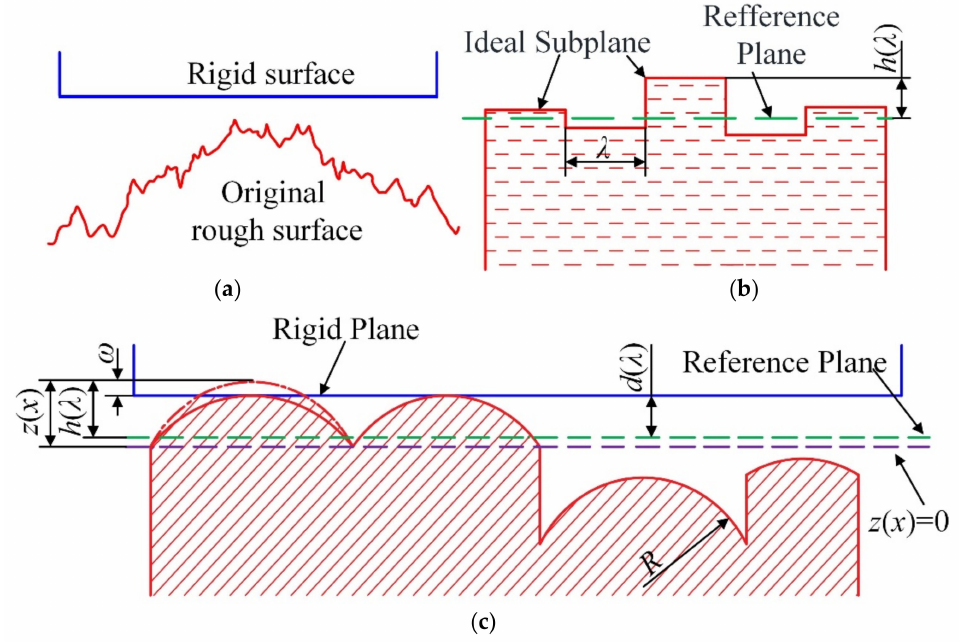
Figure 1. The contact of two rough surfaces. ( a ) The contact of two rough surfaces can be idealized as a rigid plane pressed on a deformable rough surface. ( b ) The fractal surface can be regarded as a discrete surface composed of ideal subplanes. ( c ) The fractal surface can be regarded as asperities of the same curvature